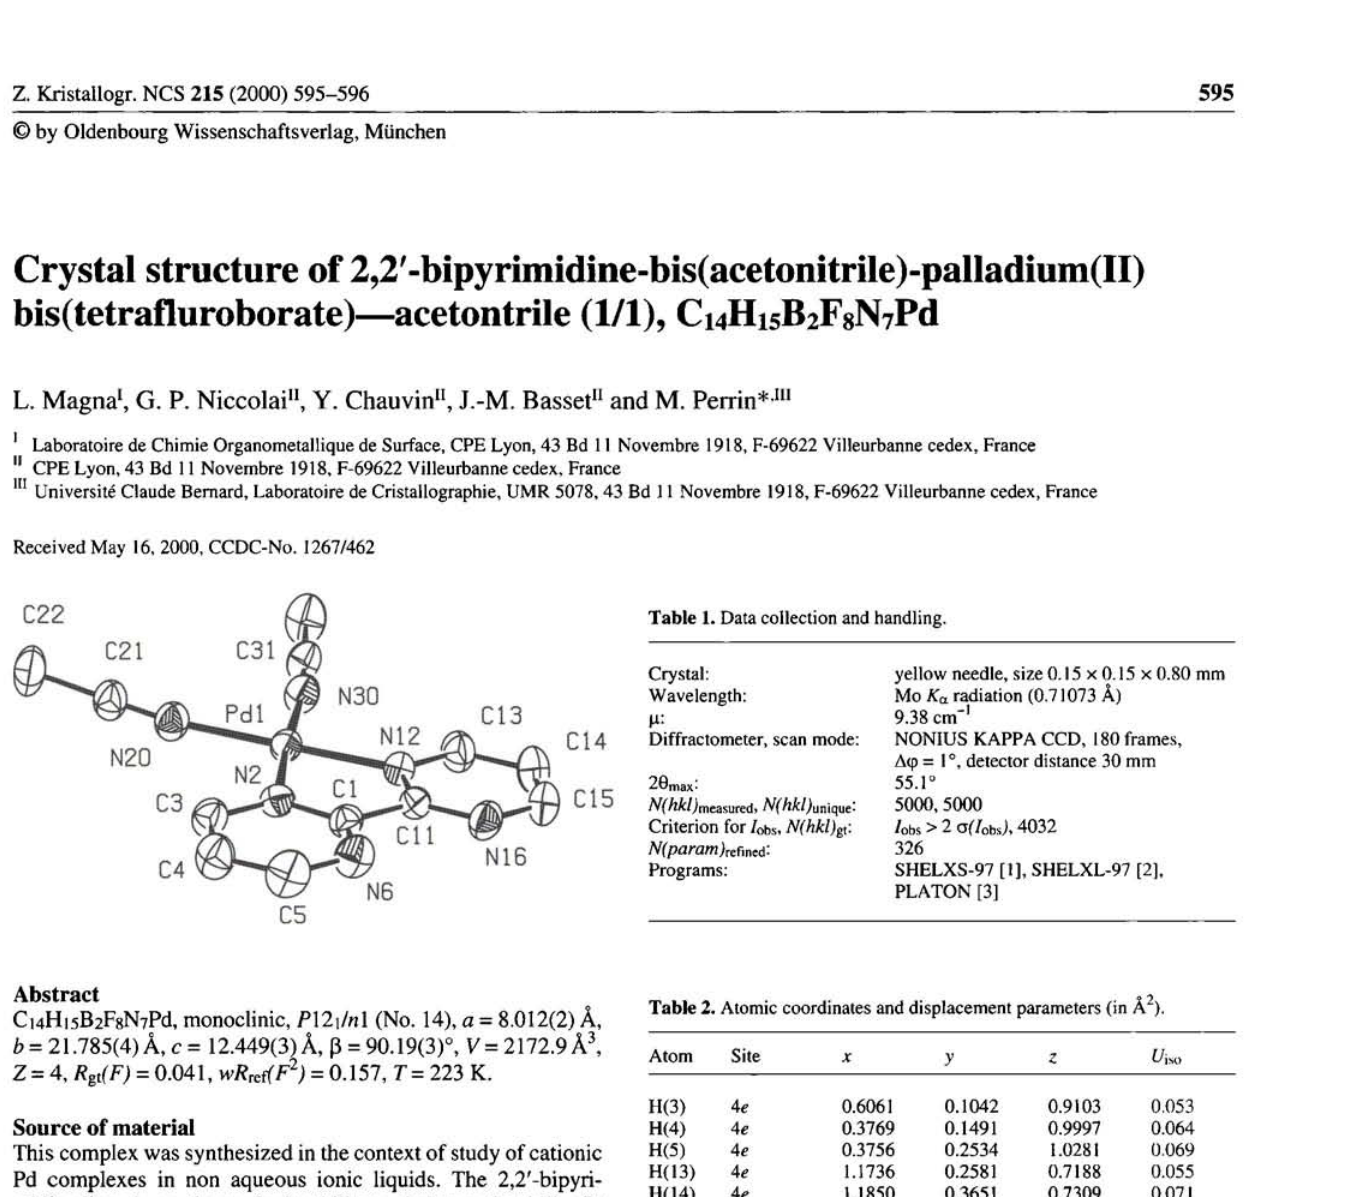
Table 2. Atomic coordinates and displacement parameters (in Â 2